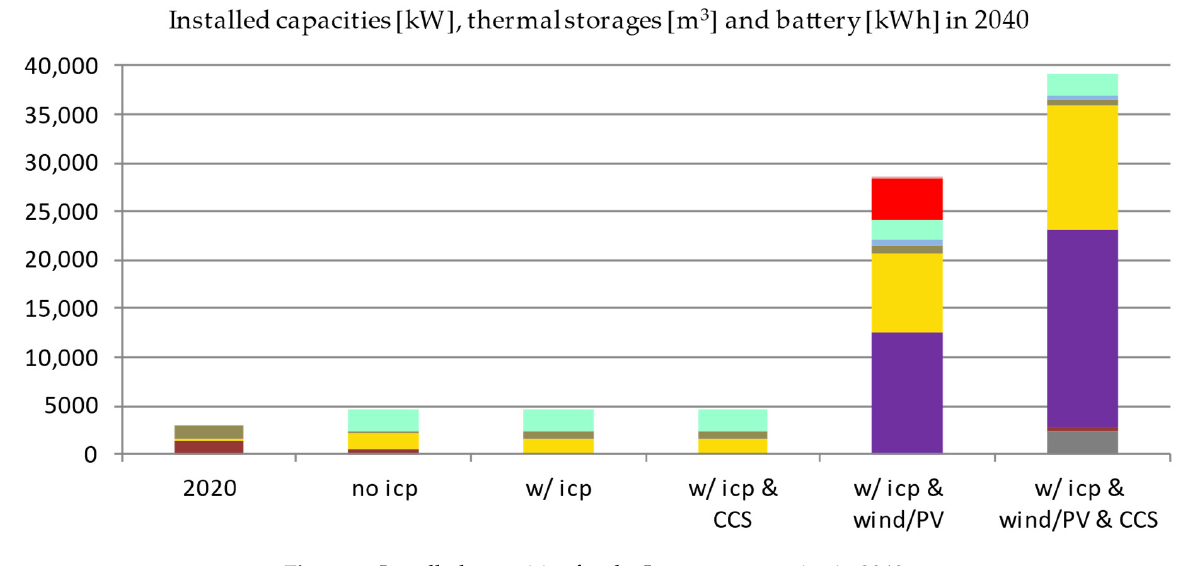
Figure 5. Installed capacities for the Japanese scenarios in 2040.